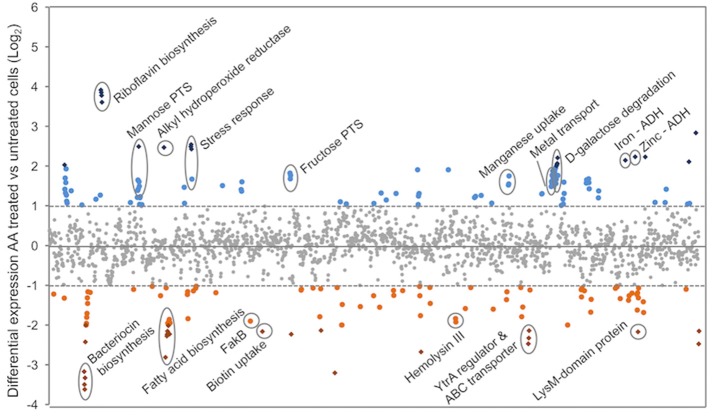
The transcriptomic responses of S. pneumoniae to AA treatment. RNA sequencing of untreated and AA-treated (62.5 μM) S. pneumoniae D39 was used to determine relative gene expression (expressed as log2-fold change compared to untreated). Each symbol represents a gene, with each gene distributed on the X-axis in accordance with locus tag numbering for strain D39. Genes upregulated upon AA treatment are presented above the X-axis (blue circles > 2-fold and blue diamonds > 4-fold), with those below the X-axis expressed at a lower level upon AA treatment (orange circles > 2-fold and orange diamonds > 4-fold). Genes of interest are annotated with their putative or characterized functions.